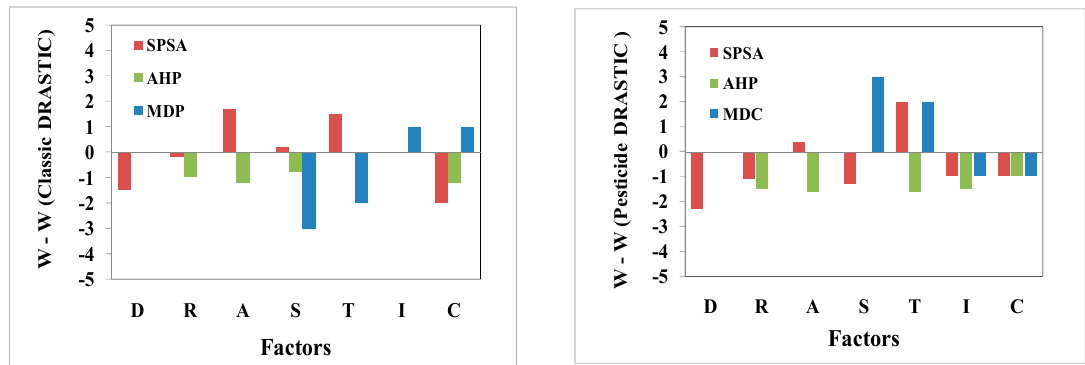
Figure 9. Plot of the difference between classic DRASTIC and pesticide DRASTIC weights and homologous values estimated by the different adjustment techniques (SPSA and AHP).